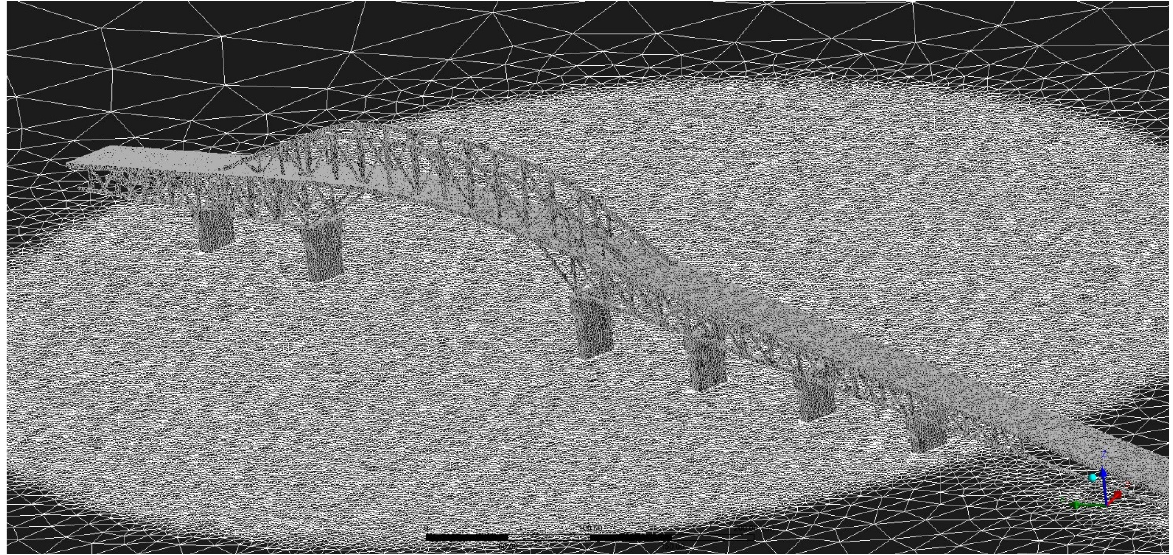
Figure A2. The size of the CFD cells gradually increases far from the bridge.